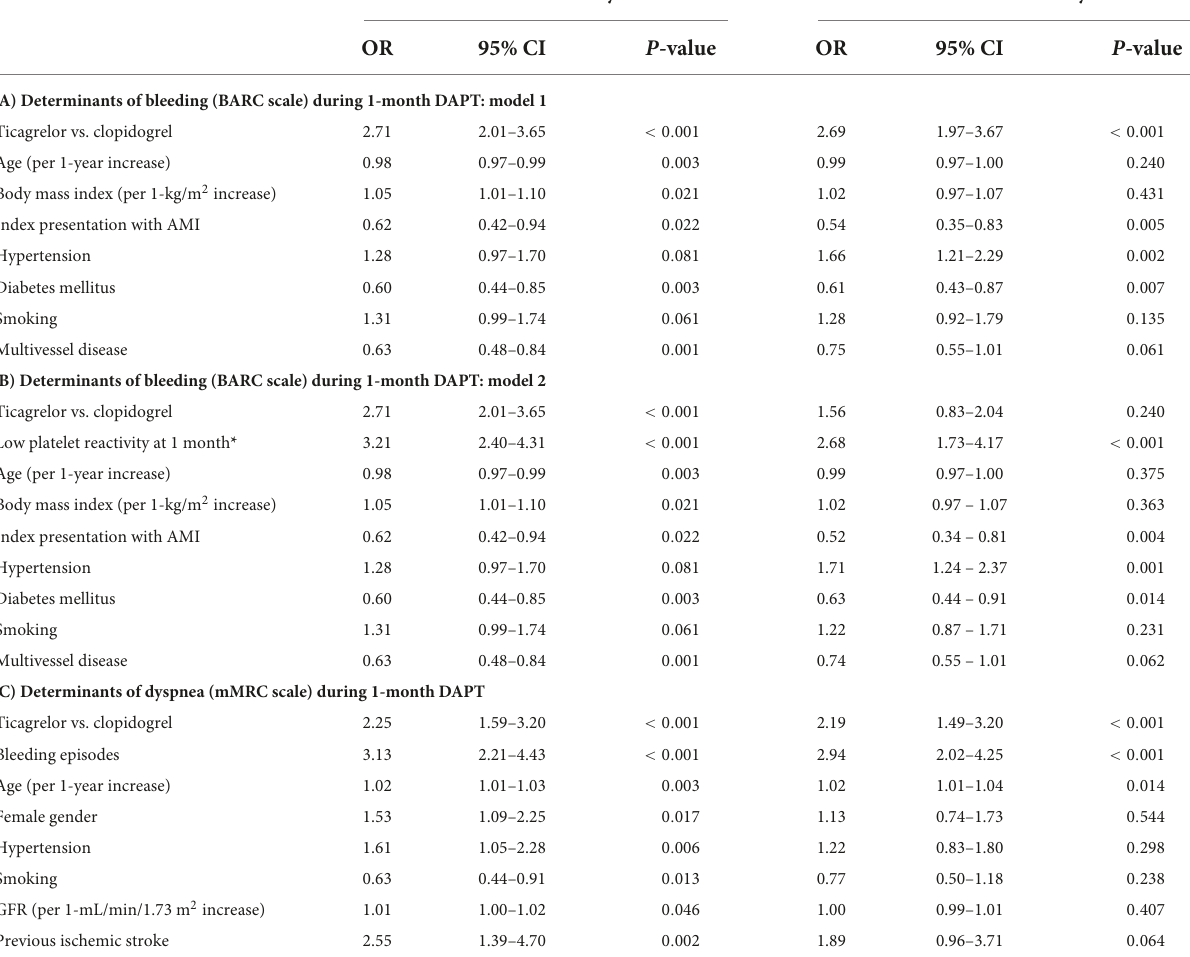
TABLE 4 Determinants of 1-month adverse